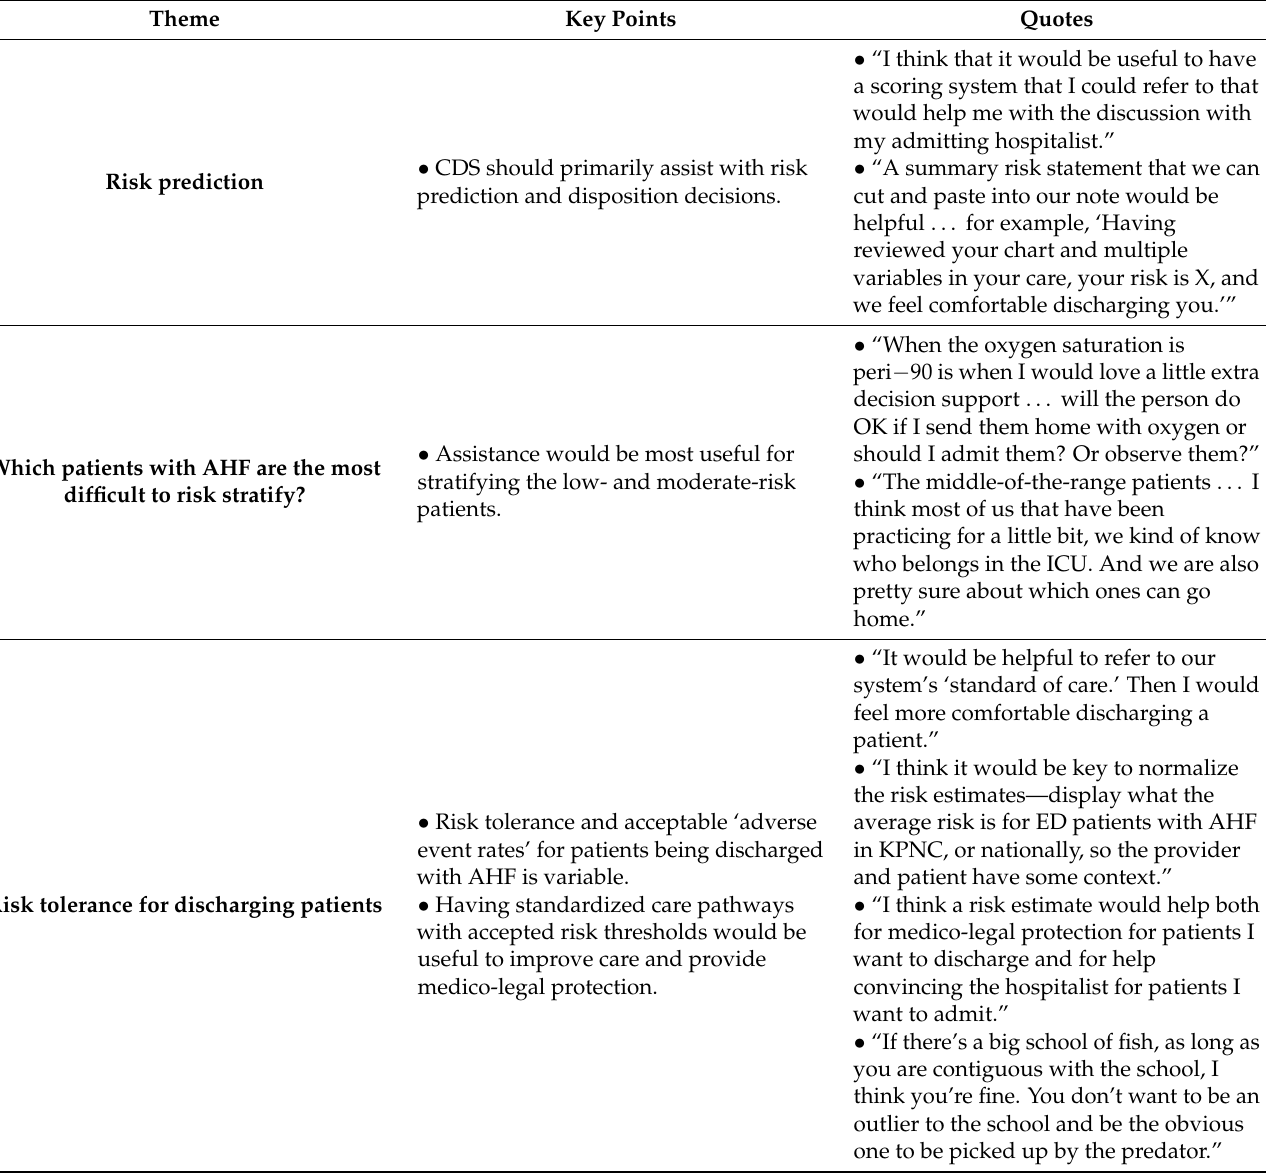
Table 2. Themes and representative quotes from qualitative interviews related to use of AHF risk prediction tools and